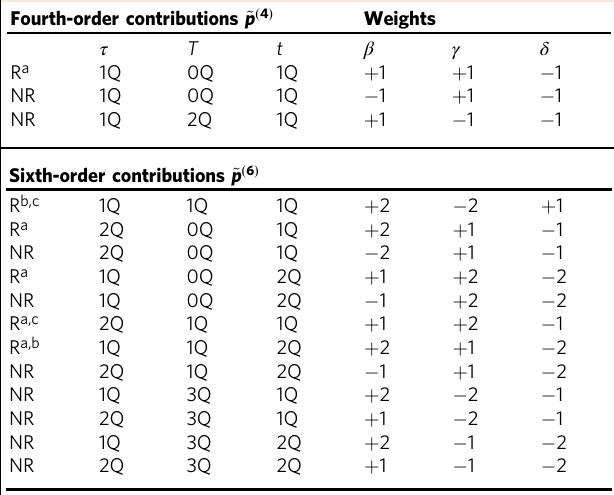
Table 1 Summary of fourth-order and sixth-order nonlinear signal